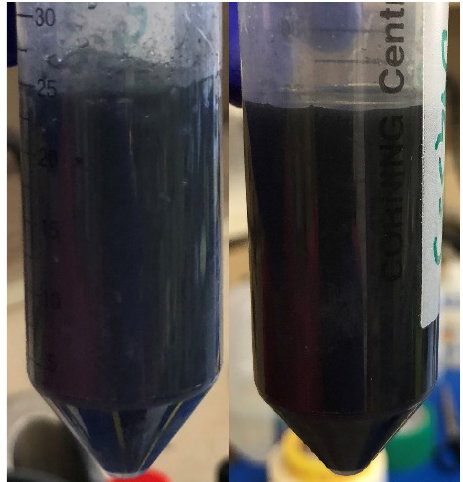
Fig. 3. After the material was combined with NaOH and shaken, note the frothiness and bubbling (Left). After the material was washed a second time with water, the solution is homogenous (right).